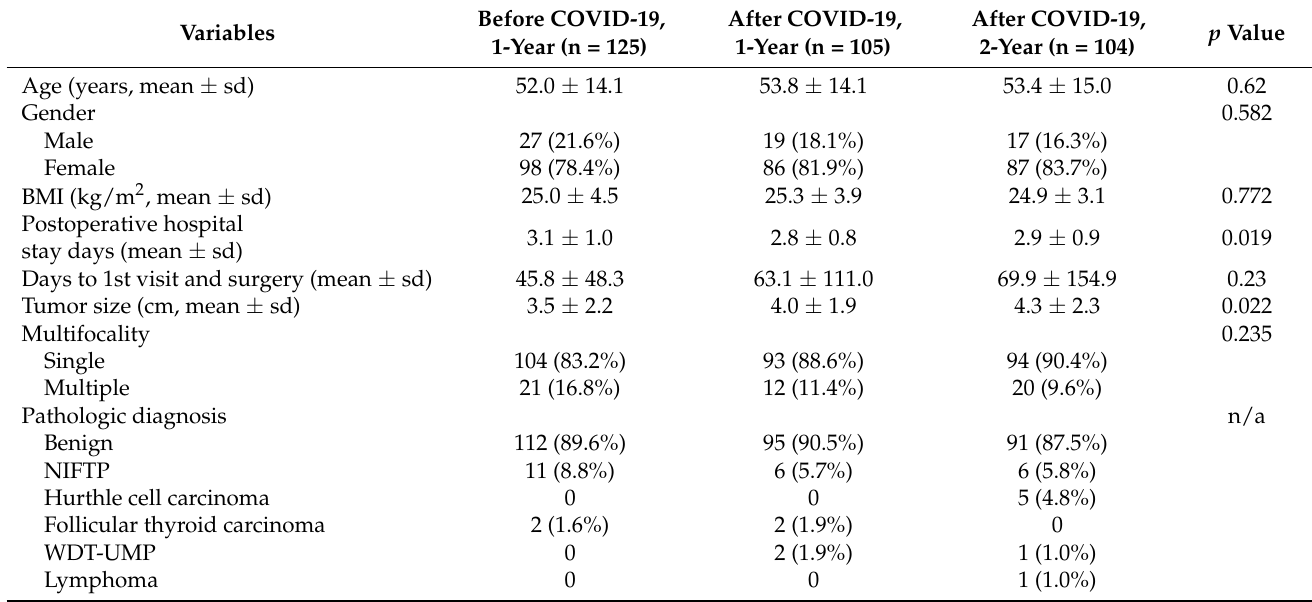
Table 3. Clinical and pathologic characteristics of follicular tumors